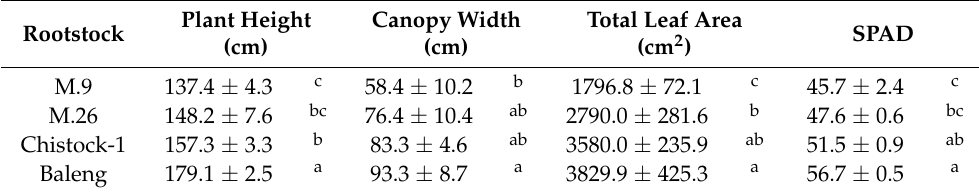
Table 2. Growth parameters and soil-plant analysis development (SPAD) values of scion-rootstock combinations. Rootstock